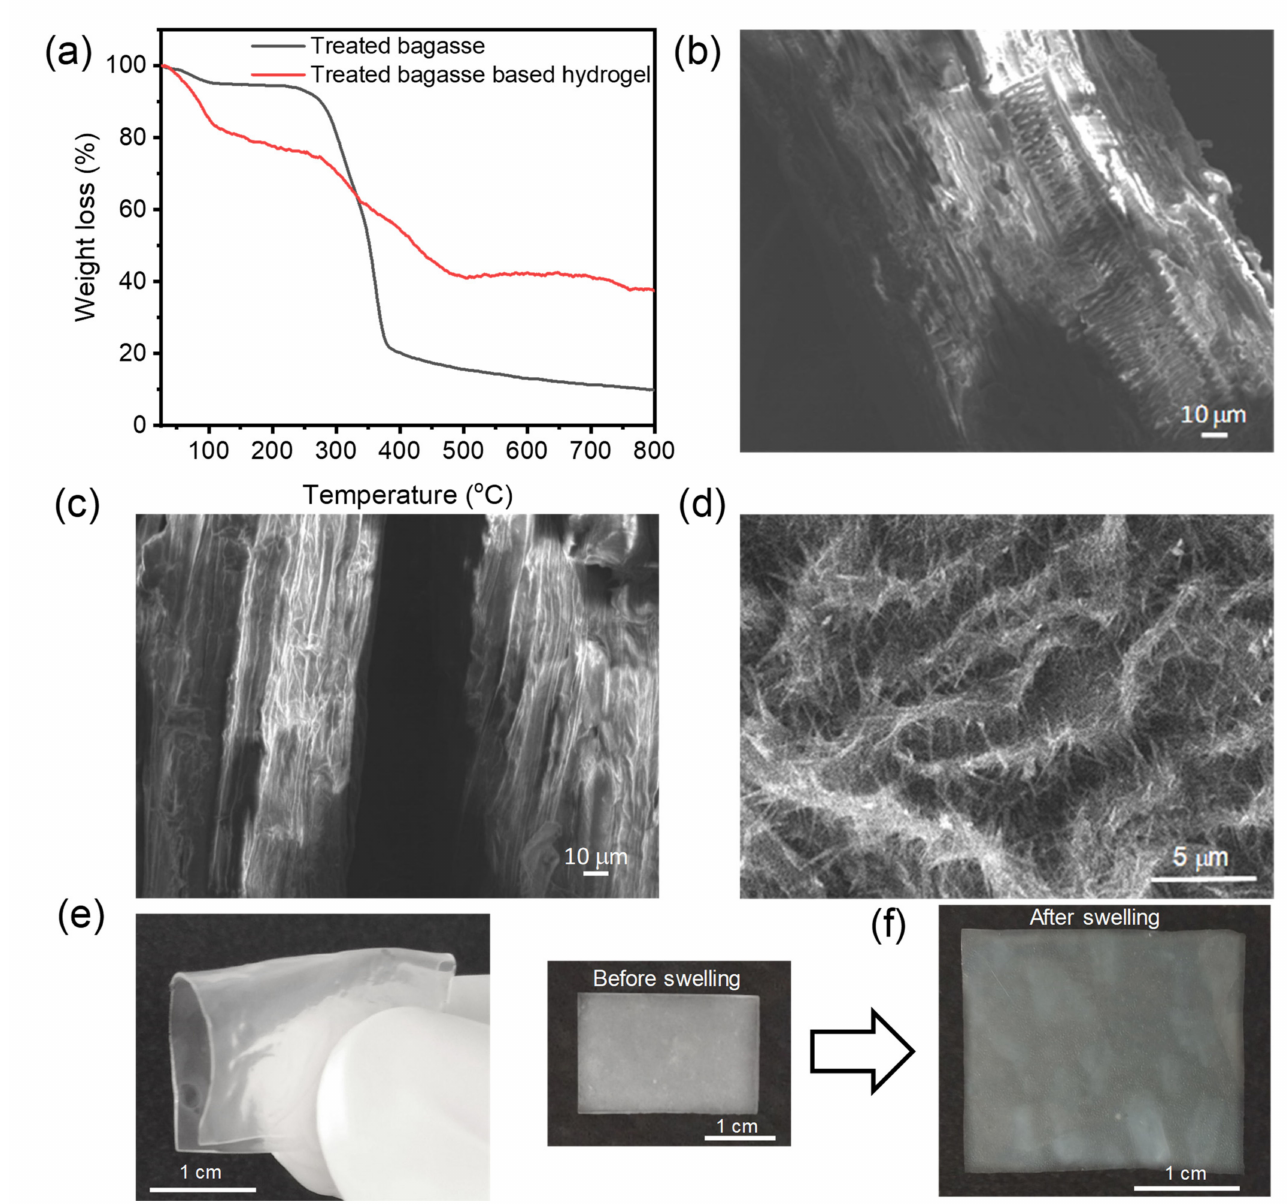
Figure 3. TGA curve of treated bagasse and its hydrogel ( a ). SEM images of sugarcane bagasse ( b ); treated bagasse ( c ); hydrogel ( d ); hydrogel film for flexibility test ( e ); and swelling capacity of the hydrogel ( f